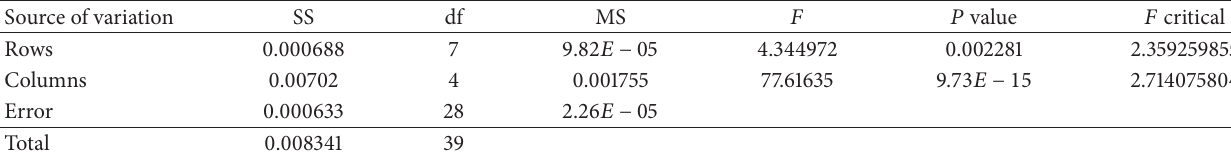
Table 6: Density test results (ANOVA: two-factor without replication).